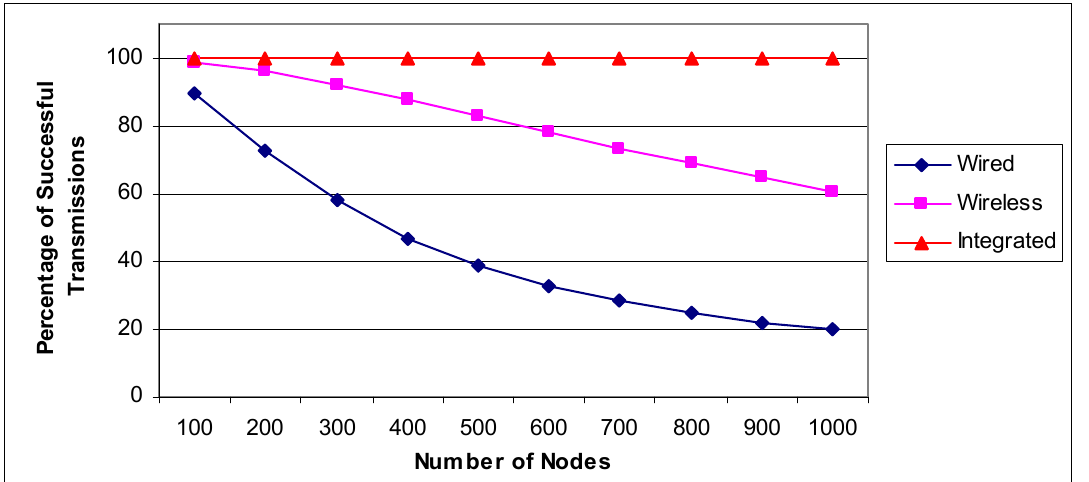
Figure 9. Impact of increasing the network length and the number of